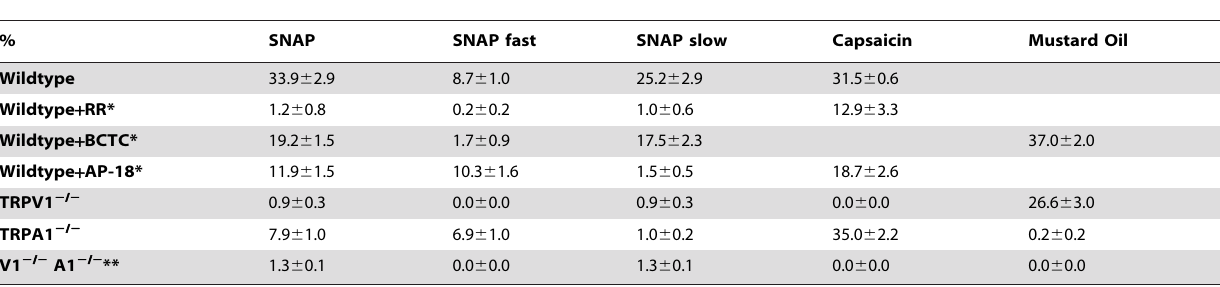
Table 1. NO donor activates DRG neurons via TRPV1 and TRPA1.